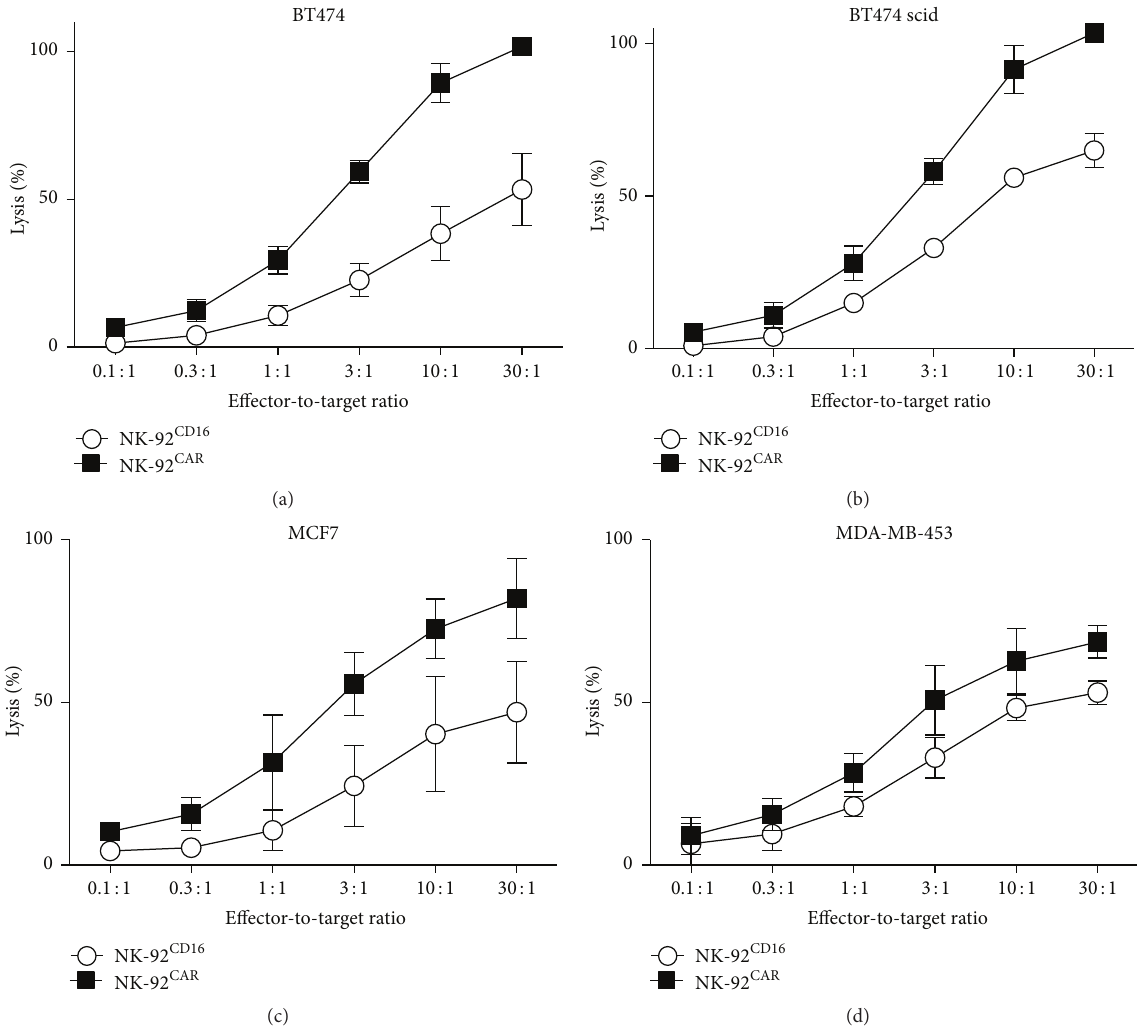
Figure 3: Comparison of direct NK- 92 CAR or indirect NK- 92 CD 16 recognition of 4 HER2 positive cell lines. Cytotoxicity was evaluated from 51 Cr release after 4 hours of incubation; the data represent the means of three independent experiments. For ADCC, cell lines were incubated in the presence of 10 𝜇 g/mL trastuzumab. In the absence of antibody BT474, MDA-MB-453 and MCF7 were not sensitive to NK activity of NK-92 (see Figure 2 and data are not shown for